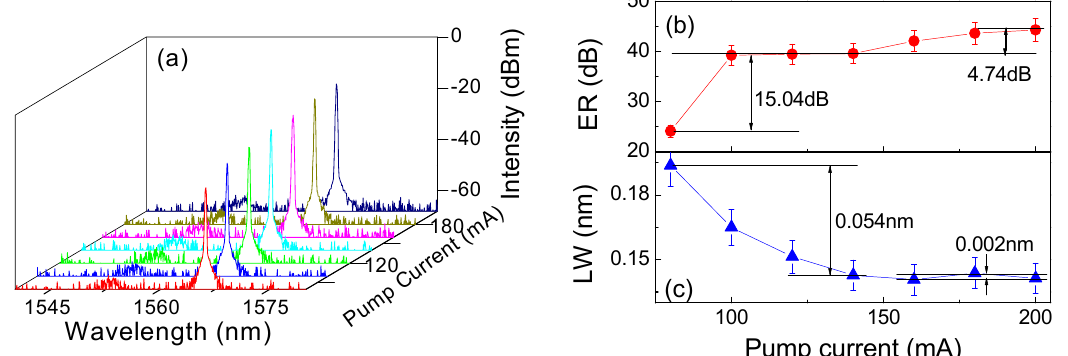
Figure 8. ( a ) The output spectra, ( b ) extinction ratio (ER) and ( c ) line width (LW) of the fiber laser ring (FRL) under a varied pump current (from 80 to 200 mA).